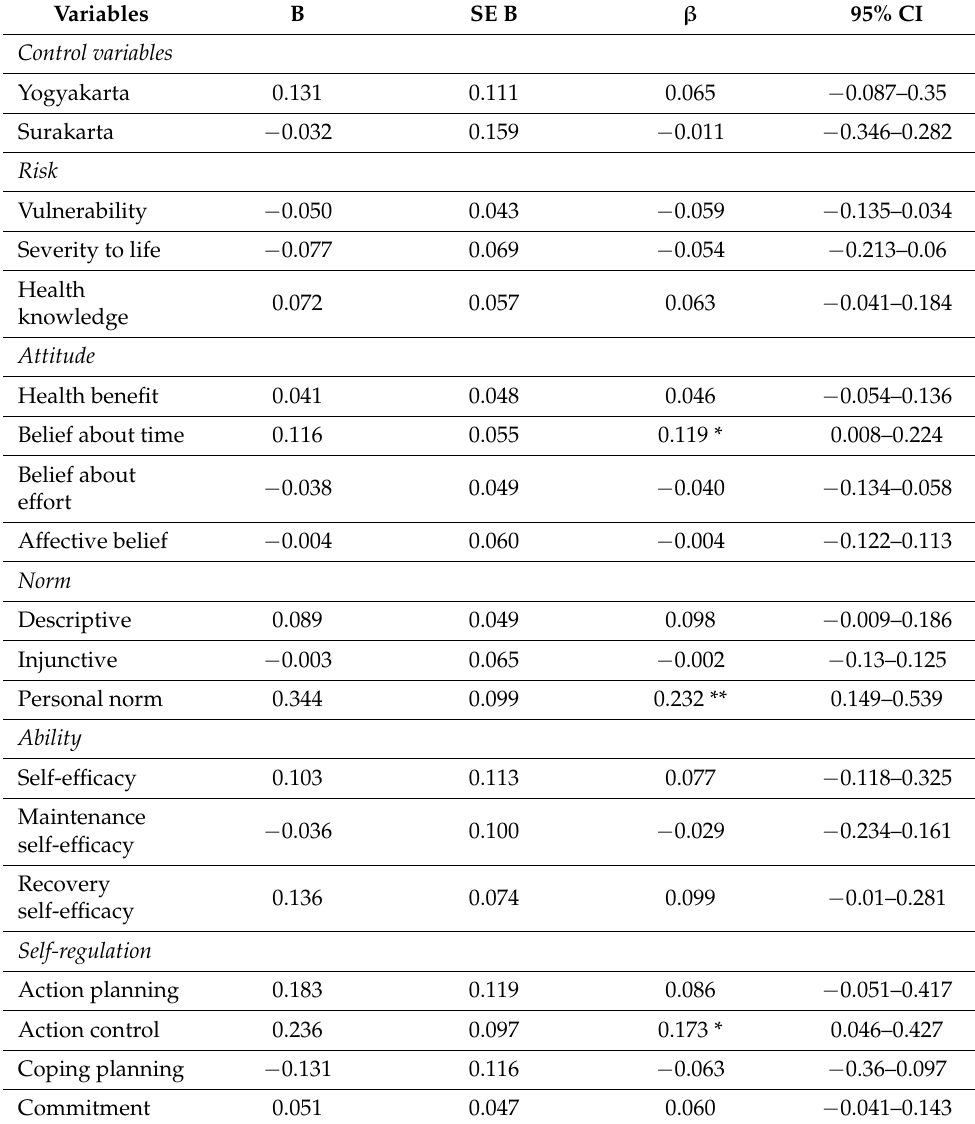
Table 3. Regression analysis of all RANAS psychological sub-factors on HWT practice. Control variables, i.e., cities, were also included in the